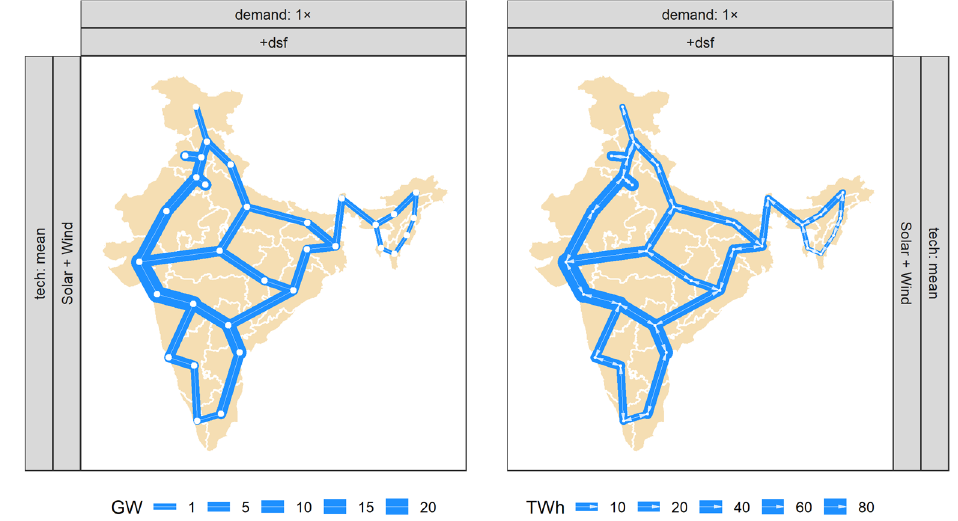
Figure 12. Optimised capacity of interregional long-distance power grid (left) with annual electricity trade flows.